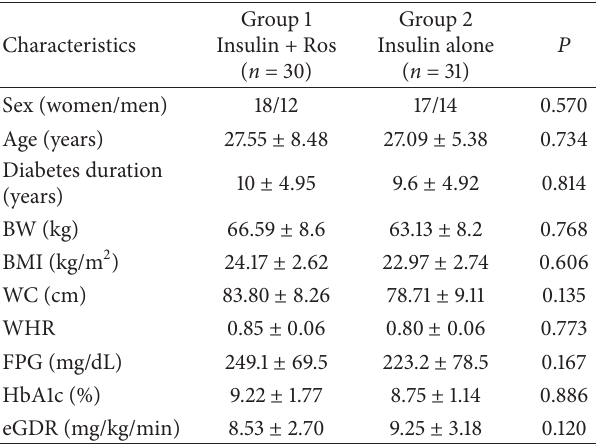
Table 1: Comparison of the demographic characteristics and base- line glycemic parameters between the